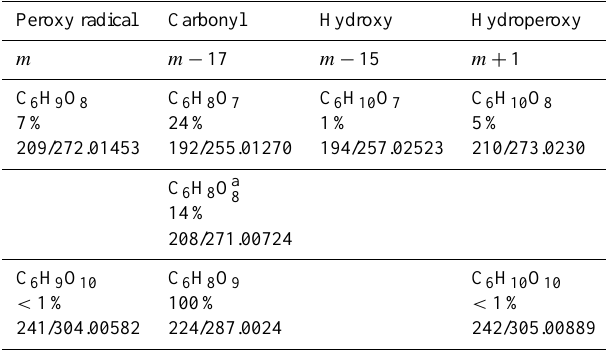
Table 5. HOM observed during ozonolysis of cyclohexene. The sec- ond header line shows at which molar masses the termination prod- ucts are expected relative to the peroxy radical with molar mass m (unit masses). Filled cells indicate that these compounds were de- tected with given elemental composition and relative intensity (sec- ond line in the same cell). Relative intensities were normalized to the largest HOM signal. The third line in the cell gives the molar mass [Da] in unit mass resolution and the precise m/z [Th] at which the molecule was detected as cluster with 15 NO − 3